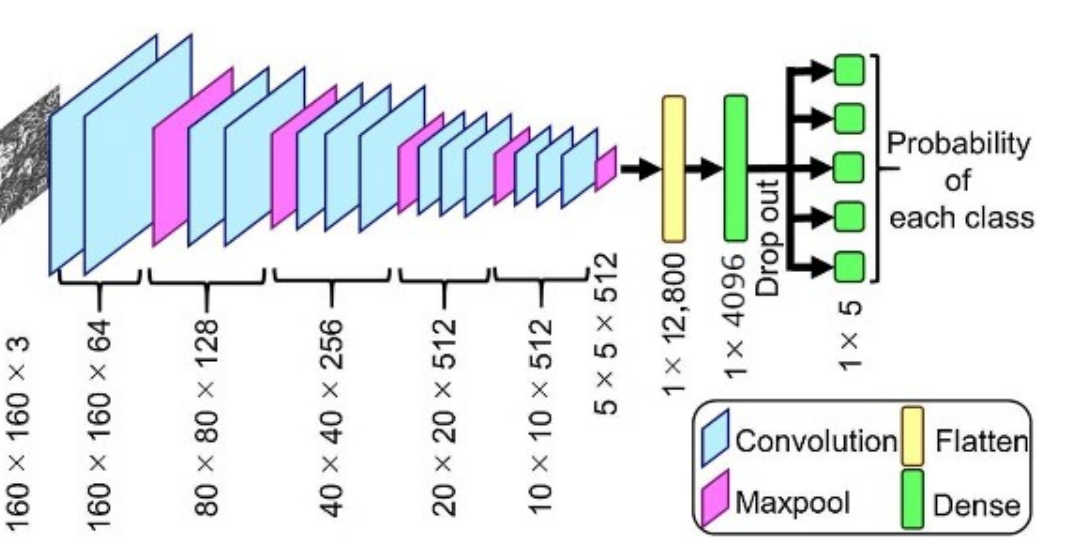
Figure 17. ResNet50 CNN model architecture.